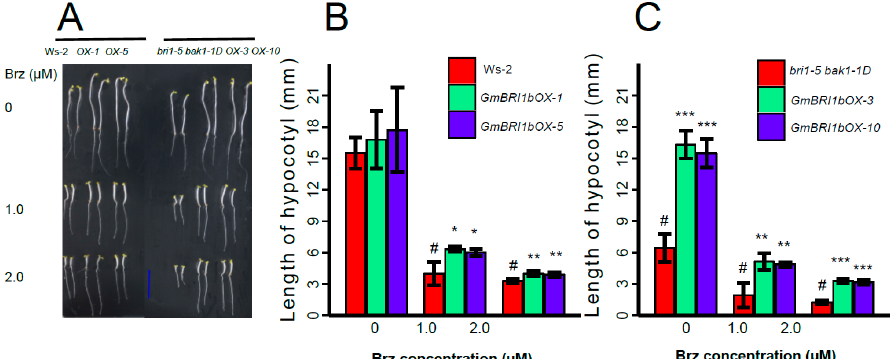
Figure 7 . Over-expression of GmBRI1b increased the tolerance to Brz in the Arabidopsis plants. Hypocotyl measurements were taken after exposure to different concentrations of Brz in seedlings of the Ws-2 wild type and the two corresponding GmBRI1b over-expression lines ( GmBRI1b-OX ) ( A , B ); and the bri1-5 bak1-1D mutant and corresponding GmBRI1b-OX lines ( A , C ). All seedlings were grown under full darkness for seven days. Results are means ± SD from three independent experiments (a total of 30 seedlings were measured) (#, control; Student’s t -test, * p < 0.05; ** p < 0.01; *** p < 0.001). Scale bar = 1 cm.